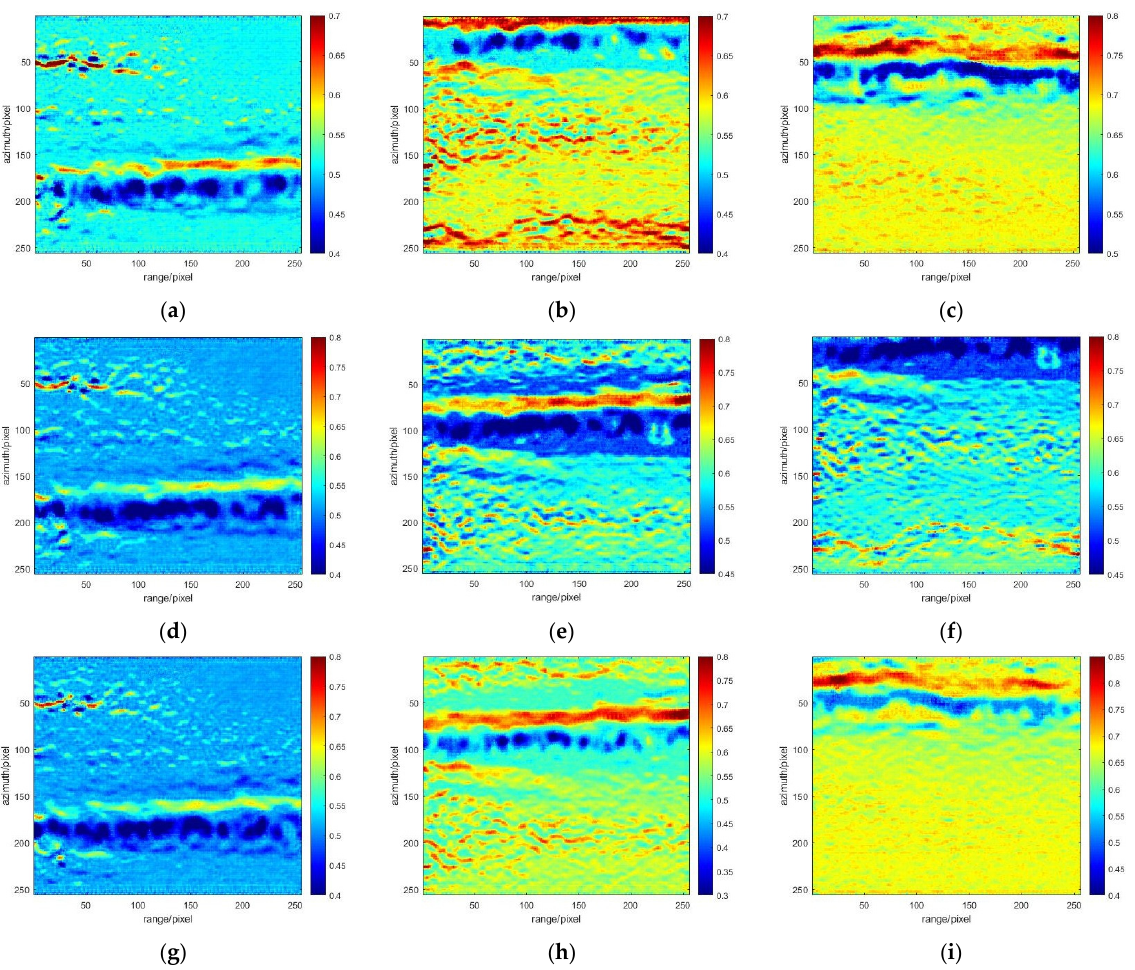
Figure 6. The estimation ocean surface current field velocity: ( a ) sample 1, ( b ) sample 2, ( c ) sample 3, ( d ) sample 4, ( e ) sample 5, ( f ) sample 6, ( g ) sample 7, ( h ) sample 8, and ( i ) sample 9.